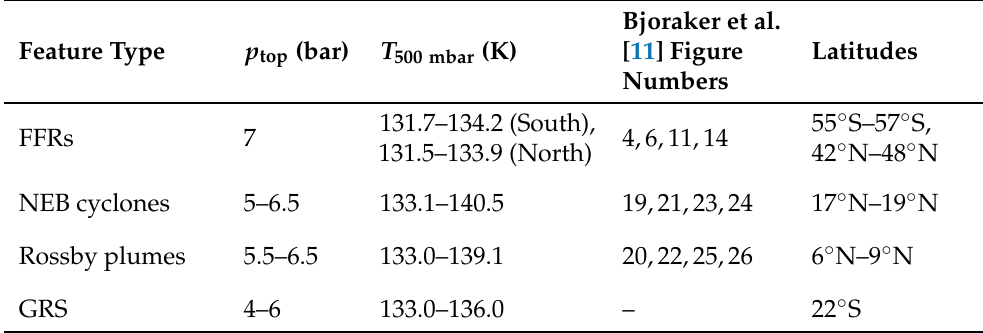
Table 3. Details of spectroscopically detected deep cloud regions (corresponding to the yellow bars in Figure 21 and the grey boxes in Figure